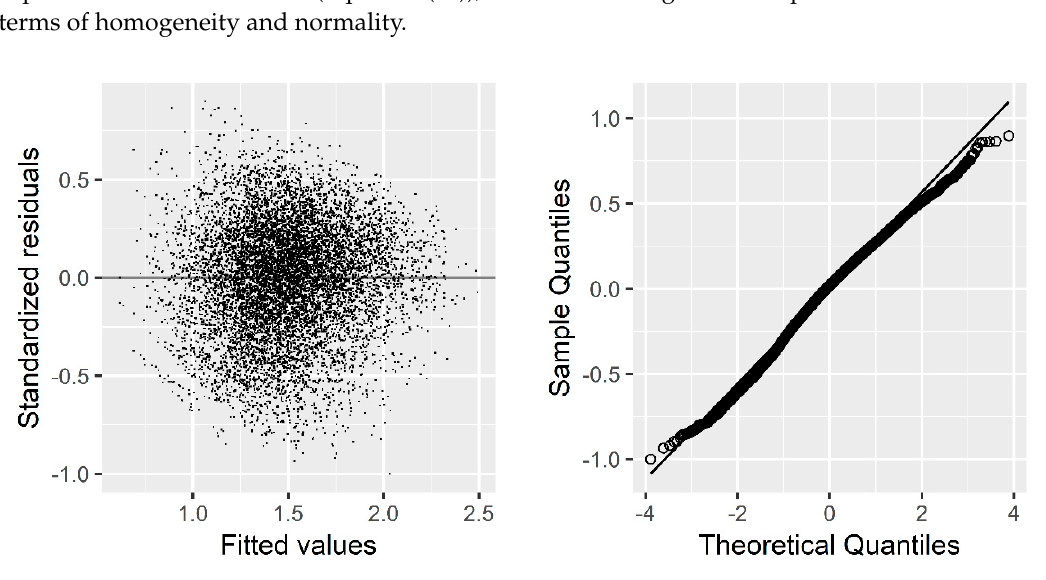
Figure 3. Residual plot and QQ plot of our final mixed-effects model.